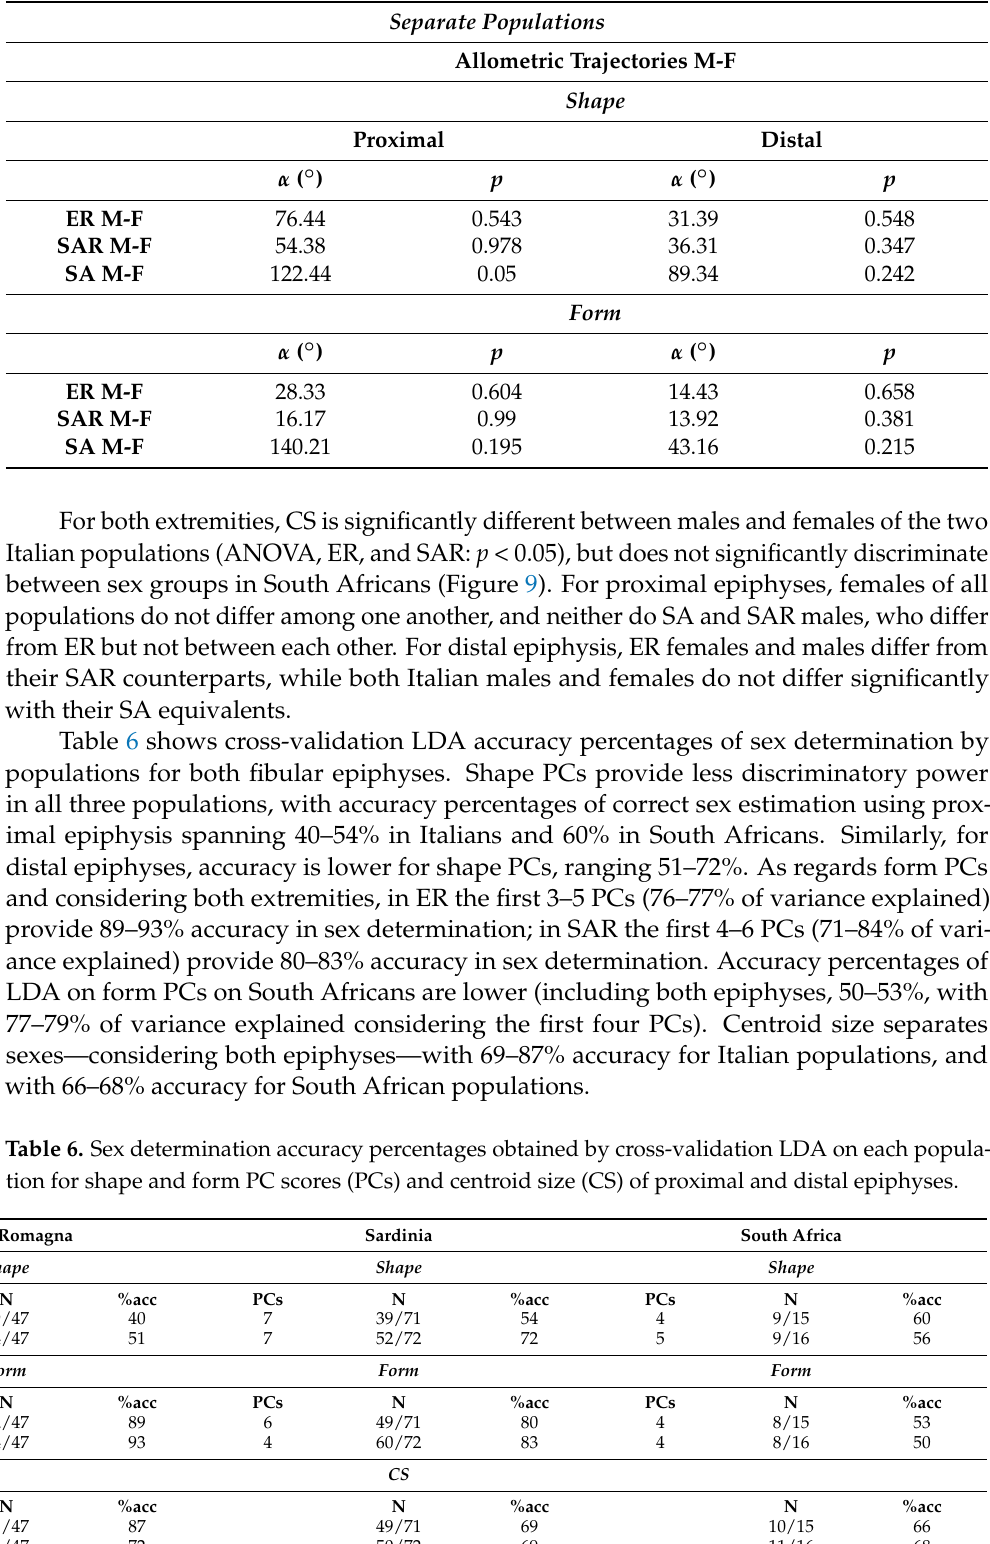
Table 5. Allometric trajectory comparisons of males and females computed for each population separately, for proximal and distal fibular epiphyses in shape and form space. α ( ◦ ) indicates the angle of divergence of each trajectory in pairwise comparison, with relative p -value ( p ).